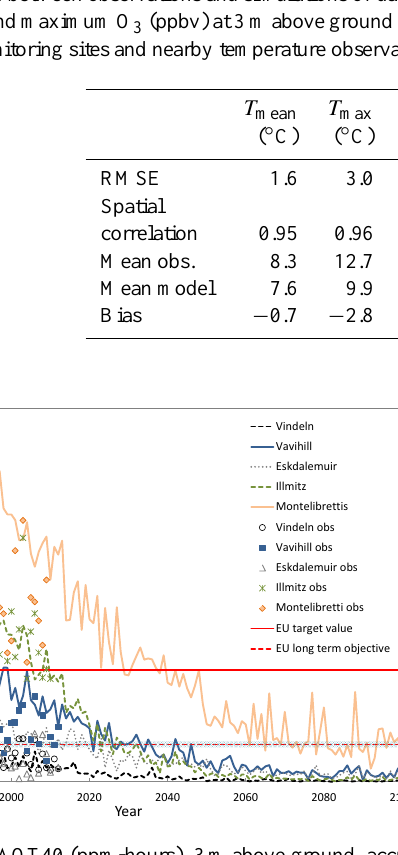
Figure 2. Modelled AOT40 (ppm-hours), 3m above ground, accu- mulated over the hours 8–20 CET during May–July 1960–2100 at five sites in Europe assuming O 3 precursor emission reductions ac- cording to the RCP4.5 scenario and climate change under the IPCC SRES A1B scenario. Discrete symbols represent AOT40 based on observations of O 3 concentrations ∼ 1990–2012 at these sites. The May–July AOT40 is used in EU directive 2008/50/EC for protection of vegetation, but is mainly relevant for crops.